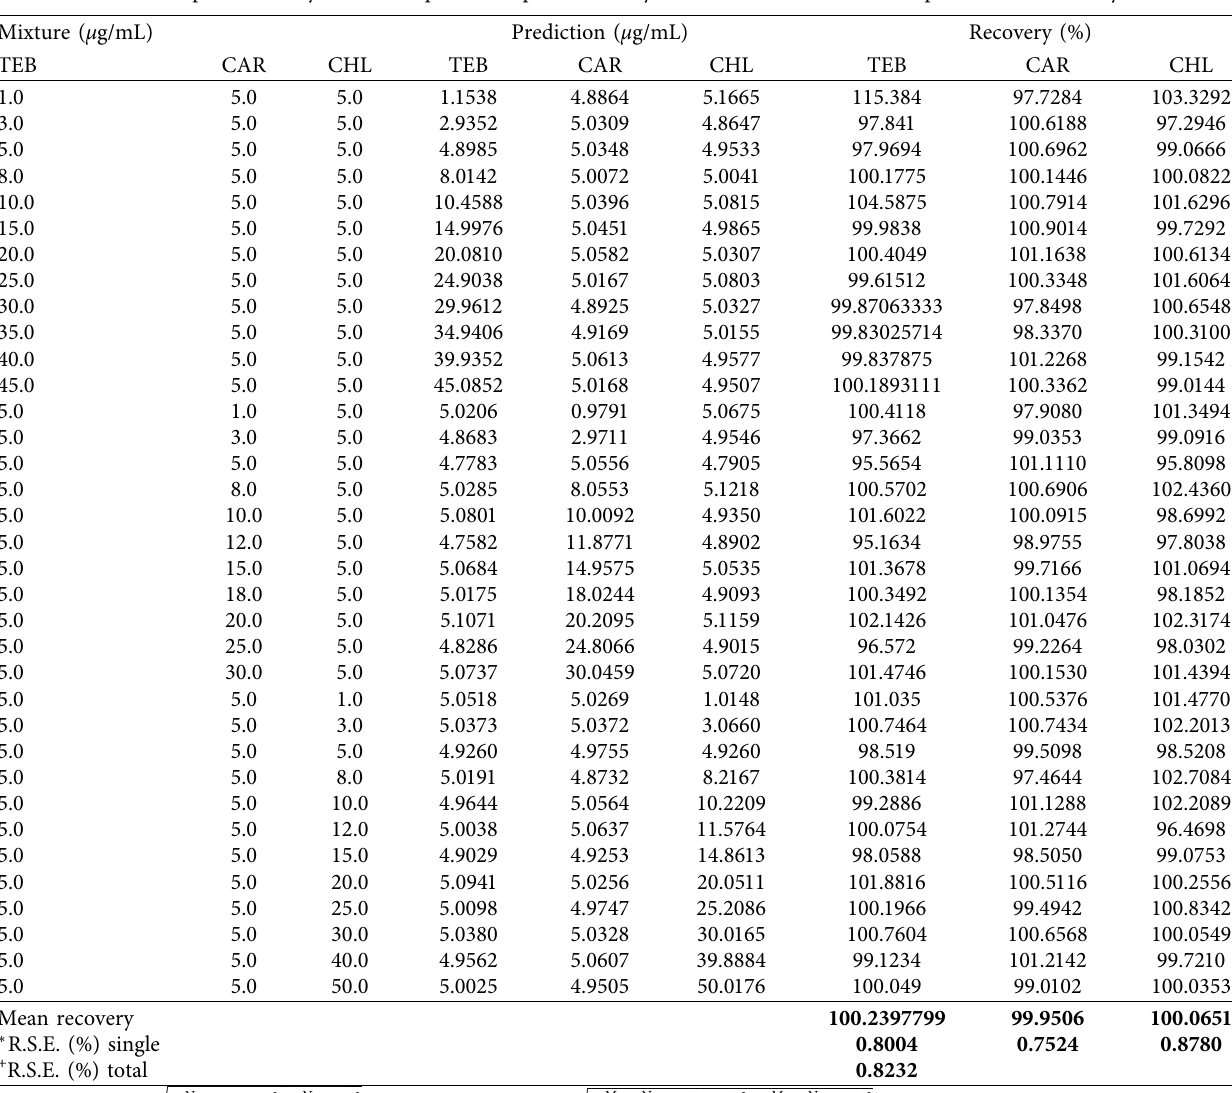
Table 7: Composition of synthetic samples, their predictions by PLS-2 model, and statistical parameters for the system.